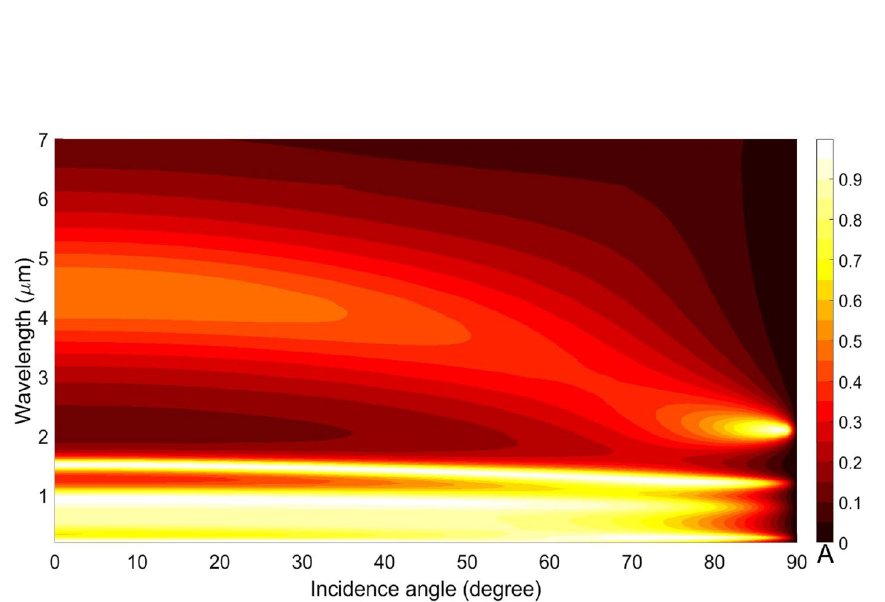
Figure 11. Absorption spectra of the structure under different values of incidence obliquity, while the other parametric and operational conditions are as used in Fig.